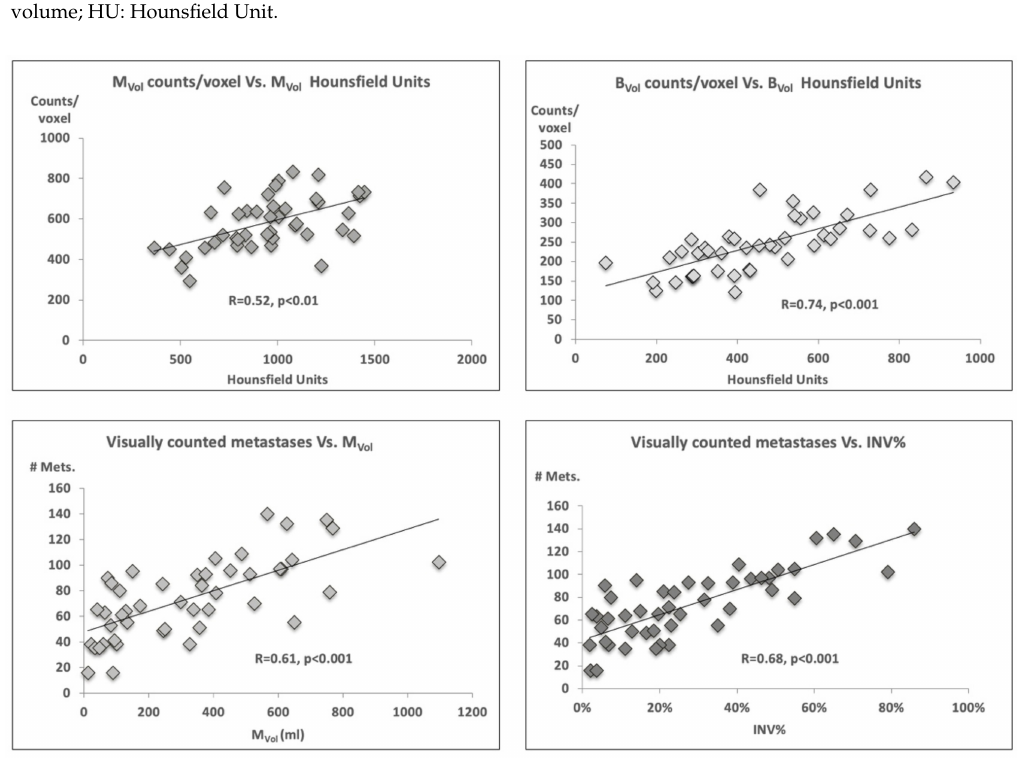
Figure 1. Correlation between counts / voxel and Hounsfield density as well as between volumes and number of metastases. A higher density corresponded to higher mean counts / voxel (top